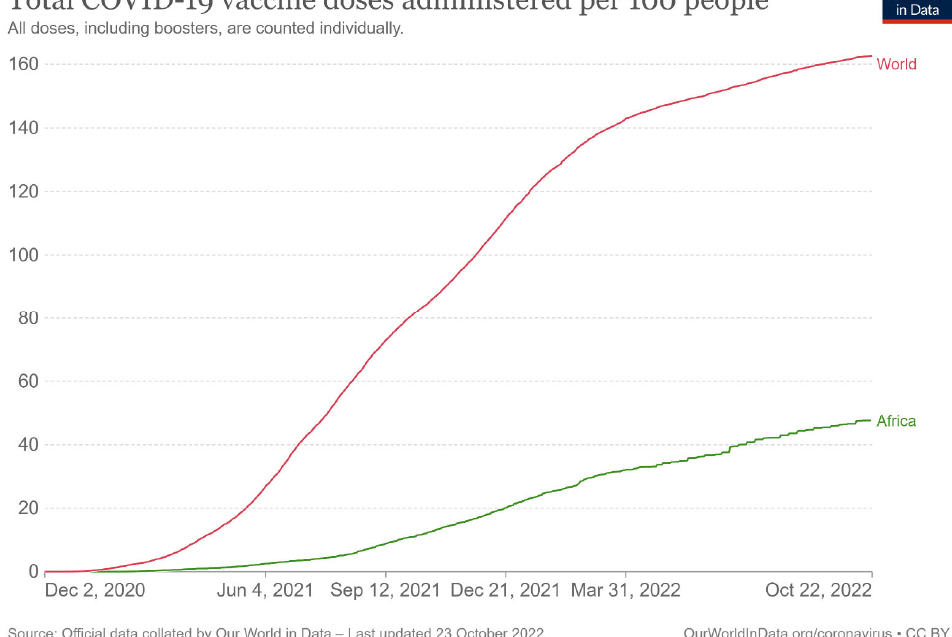
Figure 1. Total COVID ‐ 19 vaccine doses administered per 100 people [19]. COVAX [20] and Gavi, the Vaccine Alliance were very ambitious projects [21]. As and COVAX ended up using a traditional aid ‐ financed approach, which has left lower ‐ income countries wholly at the mercy of wealthy nations and profit ‐ driven companies [22].” Many developing countries are waiting for their COVAX dose [23] due to several issues (see Table 3). The WHO COVID ‐ 19 Technology Access Pool (hereinafter “C ‐ TAP”) – a non ‐ compulsory mechanism—also showed its limitations [24]. C ‐ TAP implementing partners include the Medicines Patent Pool (hereinafter “MPP”) [25], Open COVID Pledge, UN Technology Bank, and Unitaid. The first agreements were signed in October and November 2021. In October 2021, MPP and MSD—the tradename of Merck & Co., Inc. Kenilworth, NJ, USA—signed a voluntary licensing agreement to facilitate affordable access to molnupiravir in 105 low ‐ and middle ‐ income countries [26]. On the 16th of No ‐ vember 2021, Pfizer and MPP announced the signing of a Licensing Agreement for a COVID ‐ 19 oral antiviral treatment candidate have expanded access across low ‐ and mid ‐ dle ‐ income countries [27]. Another licensing agreement was signed a few days later on the 23rd of November 2021 by the C ‐ TAP [28]. On the 12th of May 2022, C ‐ TAP and the MPP finalized a licensing agreement with the United States National Institutes of Health (NIH) for the development of several innovative therapeutics, early ‐ stage vaccines and diagnostic tools for COVID ‐ 19 [29]. These recent agreements demonstrate that formal and informal mechanisms of interstate cooperation can work efficiently but as I explained a legally binding instrument will provide predictability and legal certainty to low ‐ and mid ‐ dle ‐ income countries (LMICs).